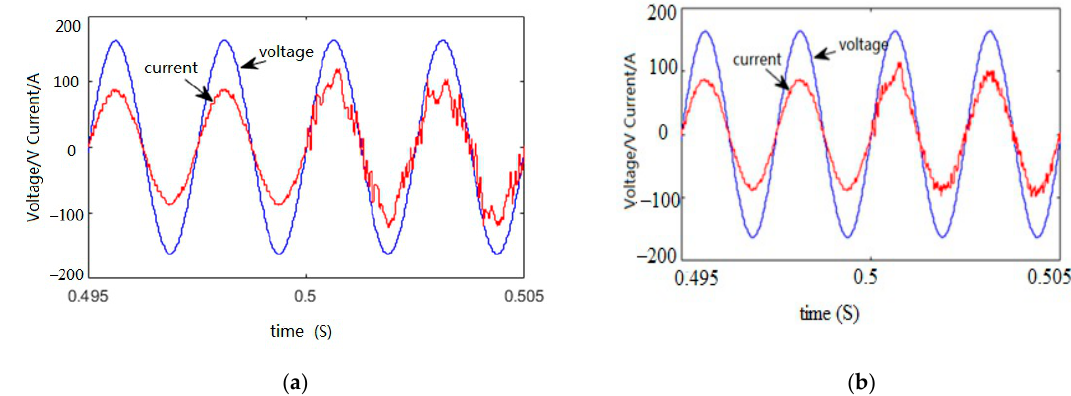
Figure 7. AC side voltage and current at inductance parameter changes ( a ) Traditional MPDPC; ( b )